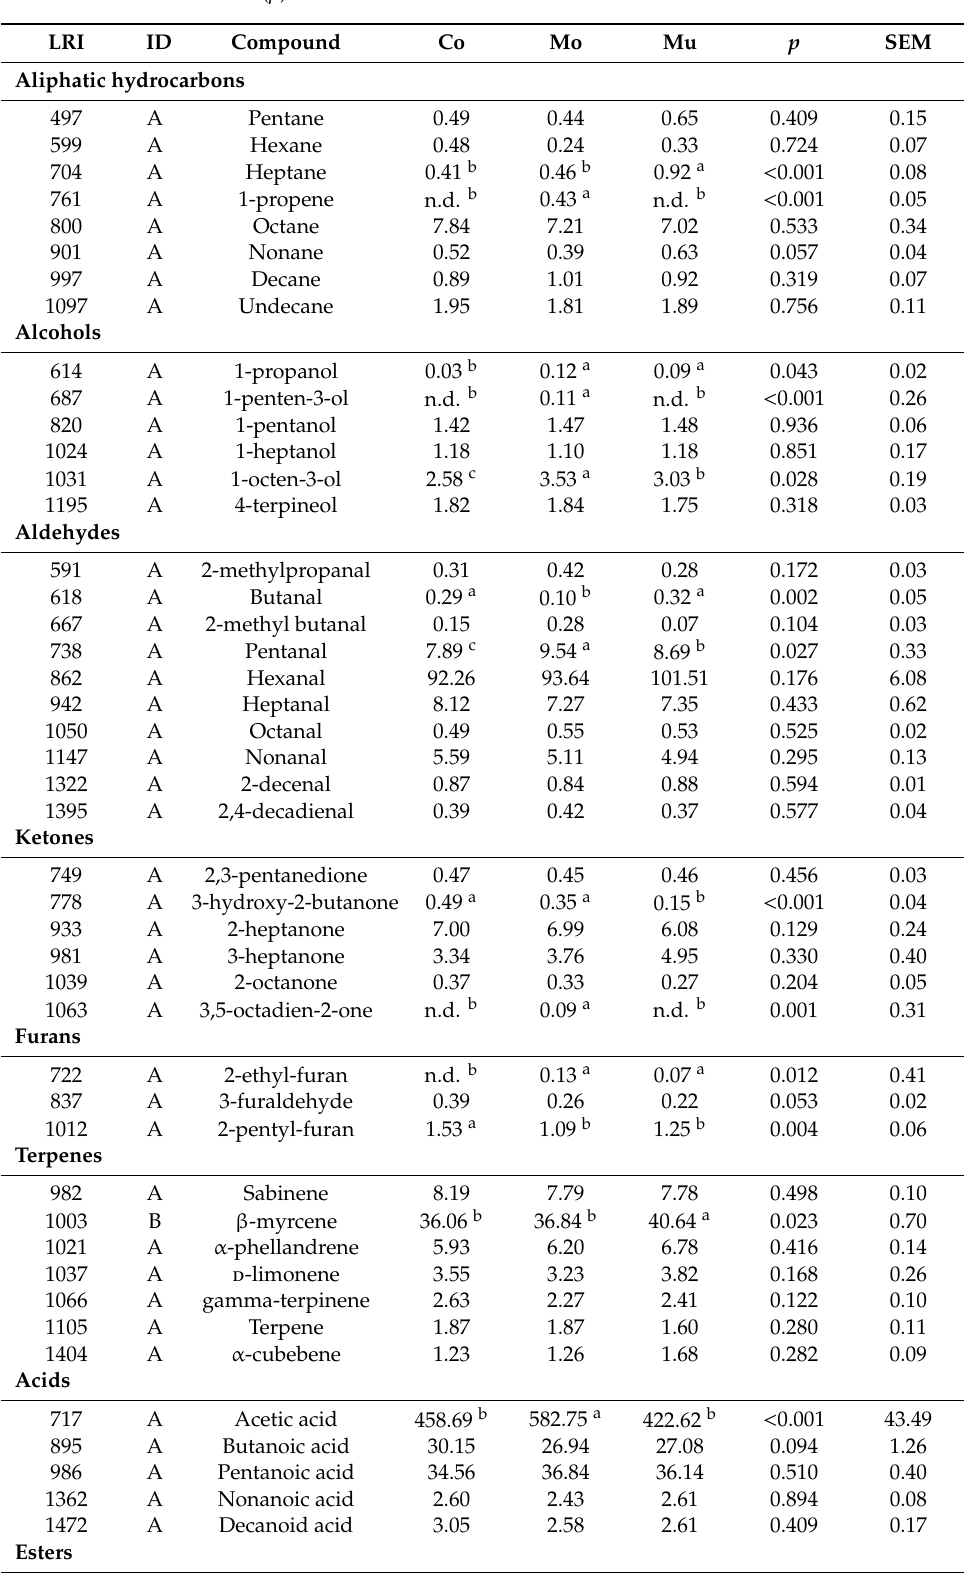
Table 2. Volatile compounds (arbitrary area units × 10 6 ) on dry-cured sausages (D-SAU) as a ff ected by enrichment with ω -3 PUFA ( p )